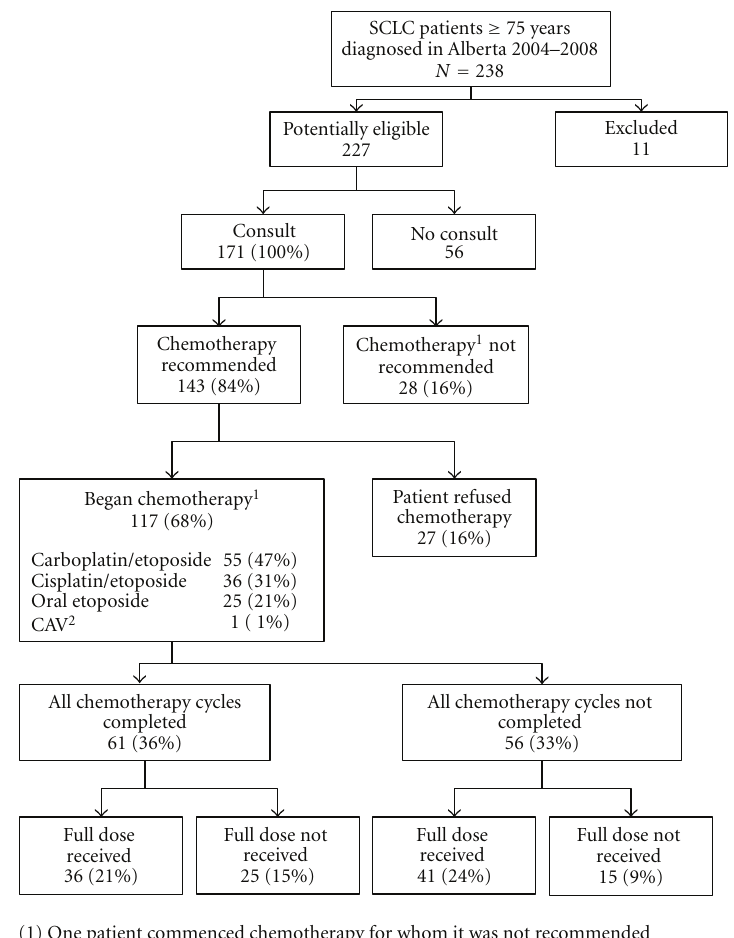
Figure 1: Flow chart of the number of patients included in the study, had a consult, were recommended chemotherapy, received it, and completed